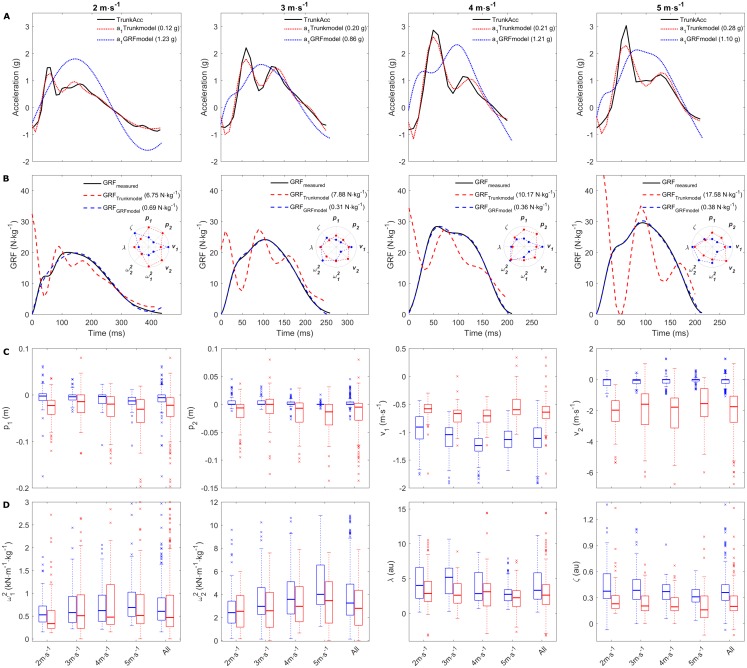
Representative examples of the upper mass acceleration, GRF and median ACCparam and GRFparam.Representative examples of a single stride from multiple subjects. (A) display the measured trunk accelerometry and the MSD-model’s upper mass acceleration, and (B) display the measured, predicted and replicated GRF. The RMSE for the trunk accelerometry fitting and GRF predictions are displayed in the brackets for the individual examples. The inserted polar plots display the estimated model parameters (in unscaled values) from the two approached for the representative examples. (C and D) display the average median, 25th and 75th interquartile range for the ACCparam and GRFparam within and across the individual running speeds. A total of 33 extreme outliers were removed from the ACCparam (p1: 7; p2: 8; v1: 2; v2: 13; \documentclass[12pt]{minimal}
\usepackage{amsmath}
\usepackage{wasysym} 
\usepackage{amsfonts} 
\usepackage{amssymb} 
\usepackage{amsbsy}
\usepackage{upgreek}
\usepackage{mathrsfs}
\setlength{\oddsidemargin}{-69pt}
\begin{document}
}{}${\omega }_{1}^{2}$\end{document}ω12: 1; λ: two outliers) and 15 extreme outliers were removed from the GRFparam (v1: 6; v2: 1; \documentclass[12pt]{minimal}
\usepackage{amsmath}
\usepackage{wasysym} 
\usepackage{amsfonts} 
\usepackage{amssymb} 
\usepackage{amsbsy}
\usepackage{upgreek}
\usepackage{mathrsfs}
\setlength{\oddsidemargin}{-69pt}
\begin{document}
}{}${\omega }_{2}^{2}$\end{document}ω22: 3; λ: 5, ζ: nine outliers) through visual inspection from the boxplots in (C and D) to improve the visual interpretation.